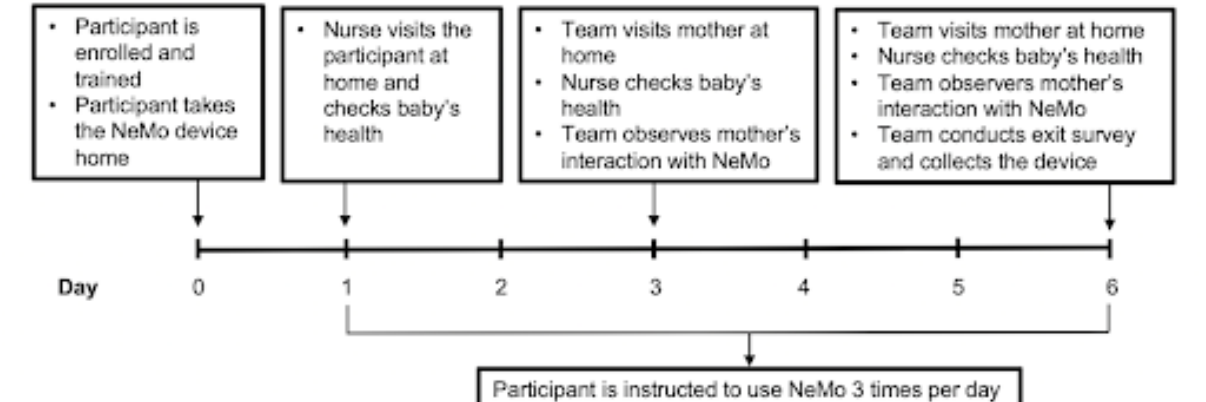
Figure 4. Study protocol for each day of the study beginning with enrollment on day 0 and ending with exit on day